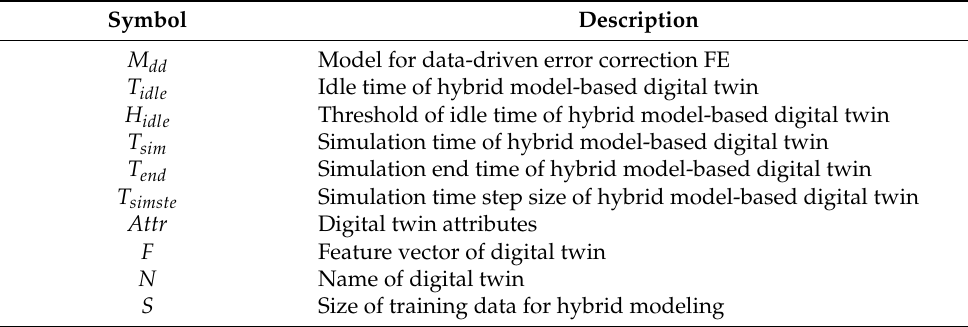
Table 2. Symbols and description for hybrid model-based digital